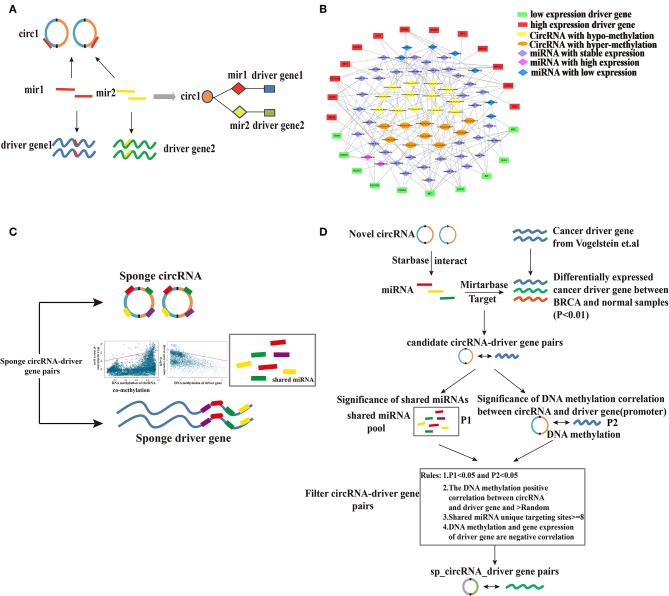
Establishment of the CMD gene network and prediction process of sponge circRNA-driver gene pairs. (A) The construction of the CMD gene network. (B) The CMD network. The ellipse represents circRNAs, the diamond represents miRNAs, and the rectangle represents driver genes. (C) Construction of sponge regulatory mechanism for circRNA and driver gene by targeting the same miRNA and prediction of sponge circRNAs. (D) Computational strategy of predicting sponge circRNA-protein coding driver genes in breast cancer.